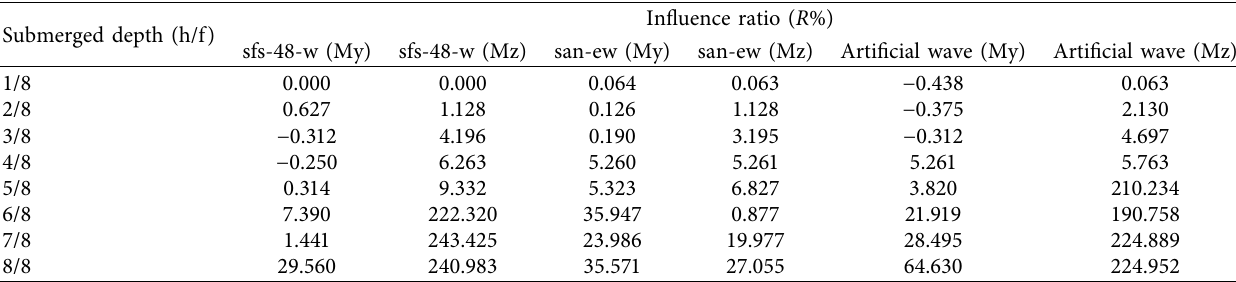
Table 6: Te relation of R and submerged depth at 4L/16 of the arch.